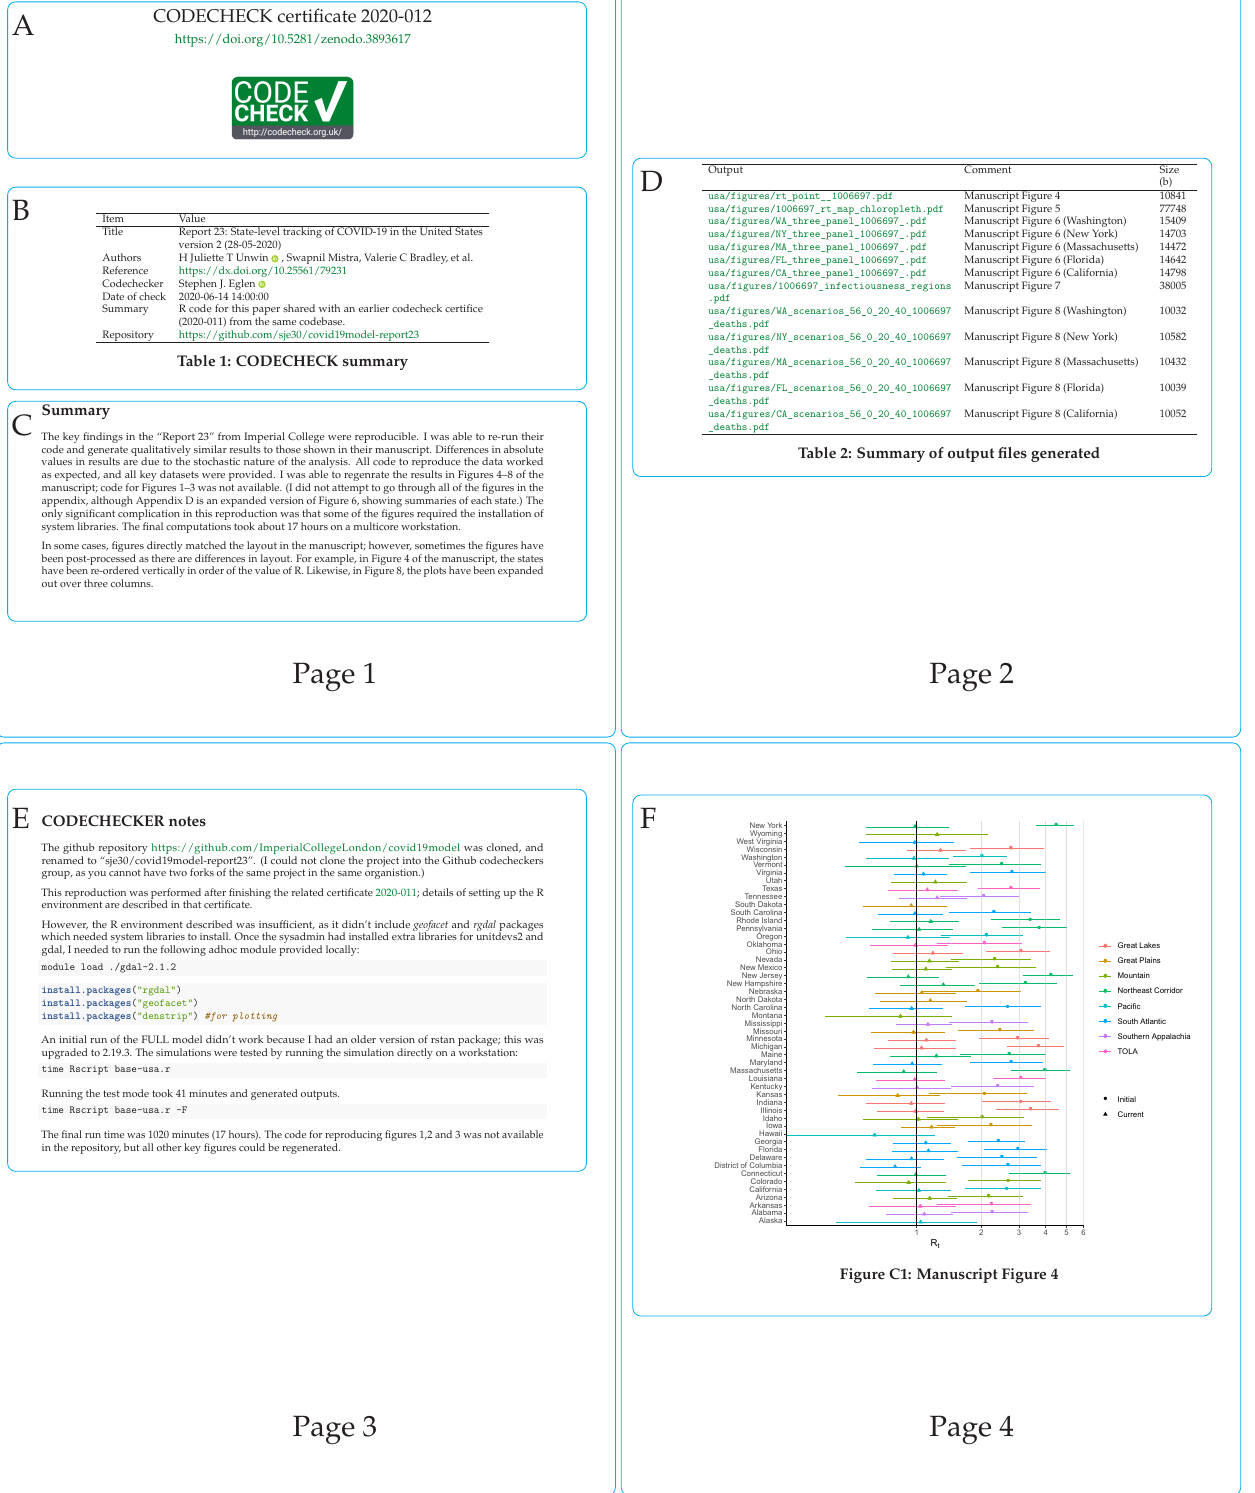
Figure C1: Manuscript Figure